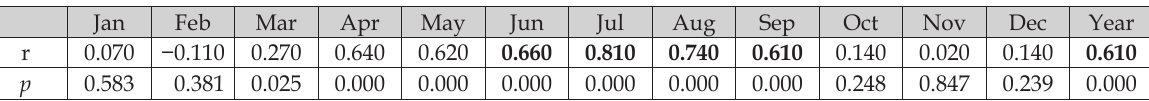
Symbols as in Table 1.